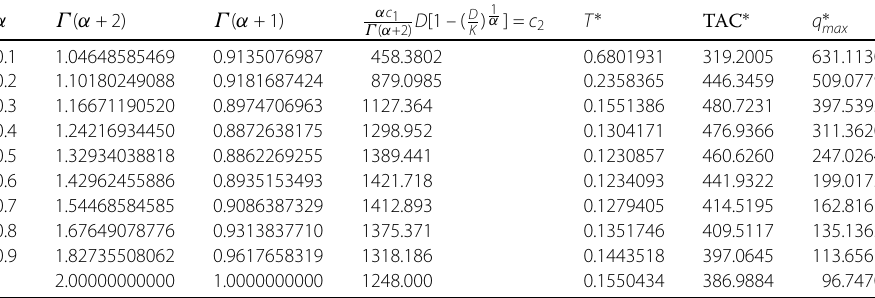
Table 4 Results for α > 0 with the fixed value β = 1 of Case 6.2